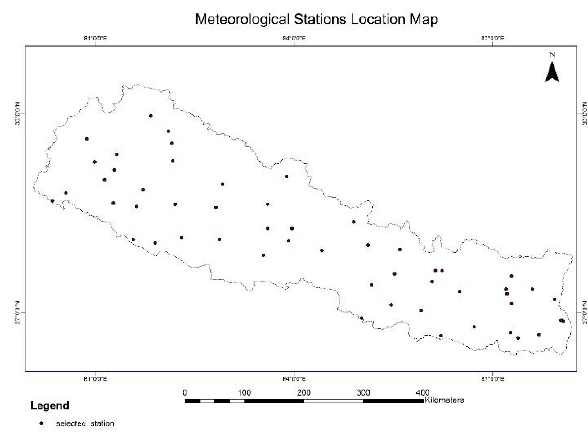
Figure 3. Map showing distribution of selected